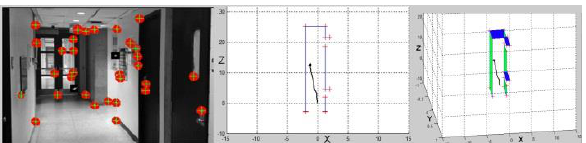
Figure 7. Left: video frame and identified point features. Middle: camera and structural corner points positions in 3D space from top view. Right: estimated layout rotated in 3D.